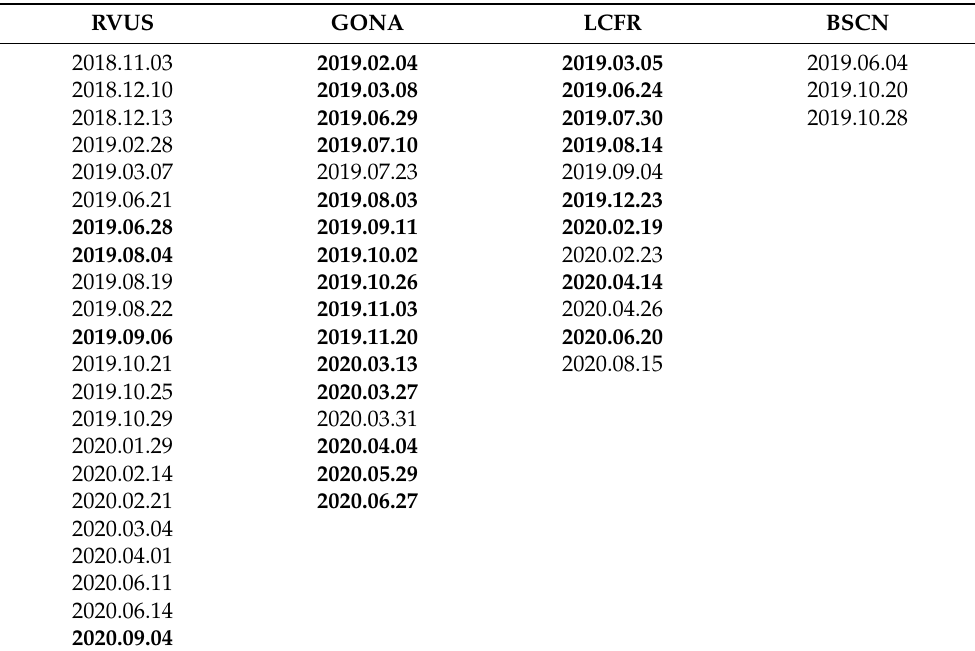
Table 2. DESIS acquisition dates (yyyy.mm.dd) at RadCalNet Sites. Bold dates are the dates when RadCalNet has measurement all day long from 9:00 AM to 3:00 PM, whereas other dates have RadCalNet measurement at certain times of the day. RVUS GONA